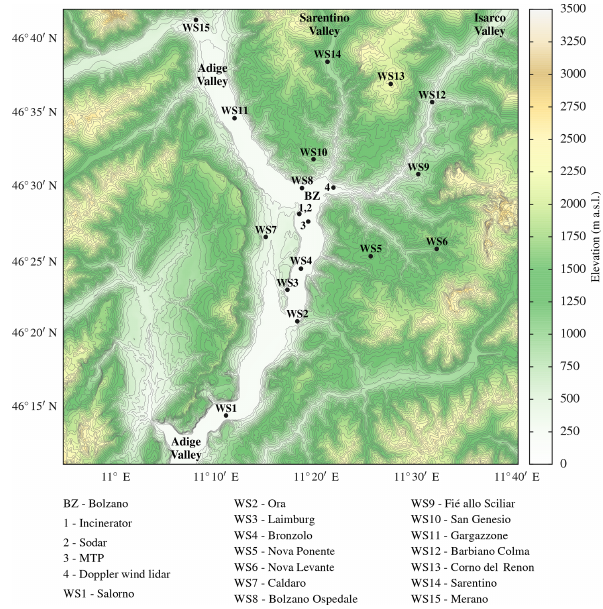
Figure 1. Overview of the study area. The map shows the oro- graphic complexity of the region and the positions of the city of Bolzano (BZ), the incinerator (1) and the meteorological monitor- ing network used during BTEX, namely 1 sodar (2), 1 microwave temperature profiler (MTP; 3), 1 Doppler wind lidar (4) and 15 sur- face weather stations